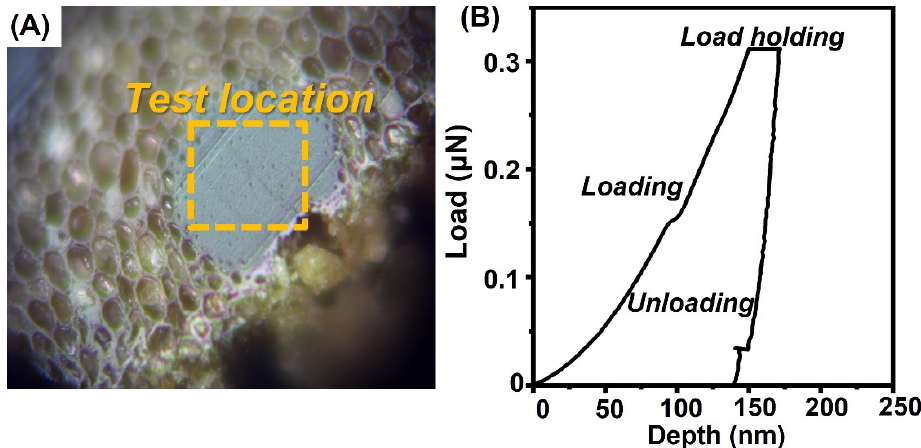
Figure 3. Bamboo cell wall test location during the nanoindentation test ( A ) and typical load-depth nanoindentation curves ( B ).